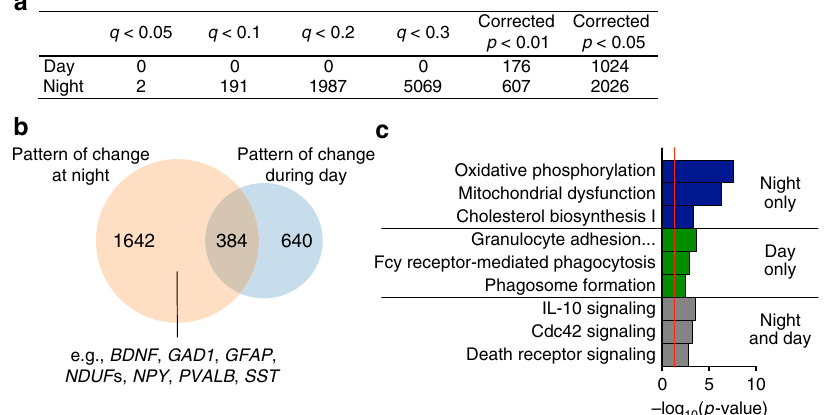
Fig. 5 More genes are differentially expressed between schizophrenia and control subjects if they died during the night. a Table showing number of DE genes during day or night at various signi fi cance cutoffs. A permutation test was used to return corrected p-values and Storey ’ s q value was used to correct for multiple testing. b Venn diagram indicating overlap in genes that are DE at p < 0.05 in schizophrenia at night and during the day. Many genes that have previously been identi fi ed as being disrupted in schizophrenia are DE only at night (e.g., BDNF , PVALB , SST ). c The pathways represented by the genes that are DE only at night are related to oxidative phosphorylation and mitochondrial dysfunction. The pathways represented by the genes that are trending towards DE only during the day relate to immune function. For the genes that are DE both during the day and night, the top pathways are related to